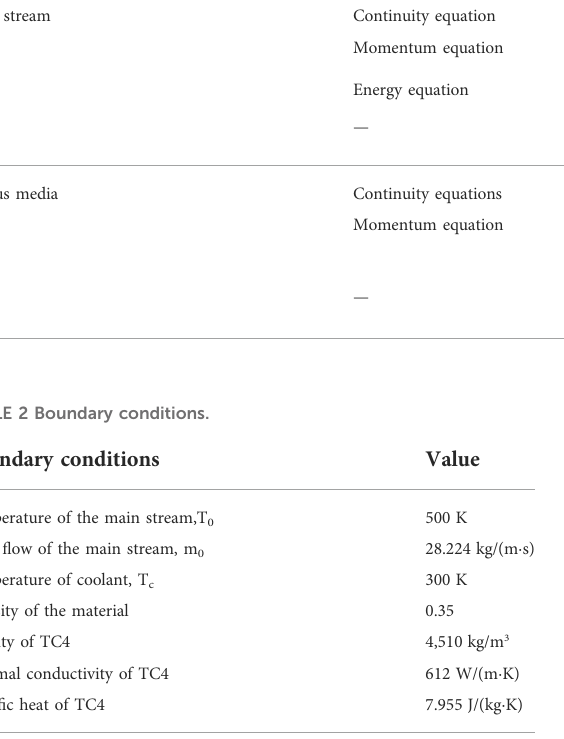
temperature after transpiration cooling.